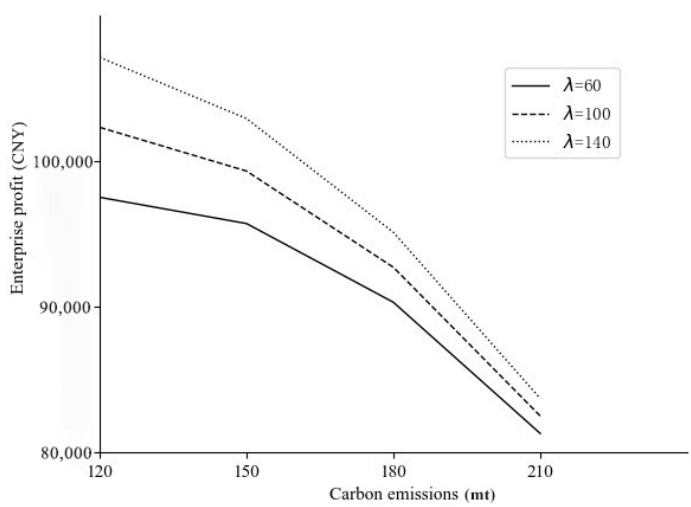
Figure 3. The impact of carbon emissions on corporate profits.